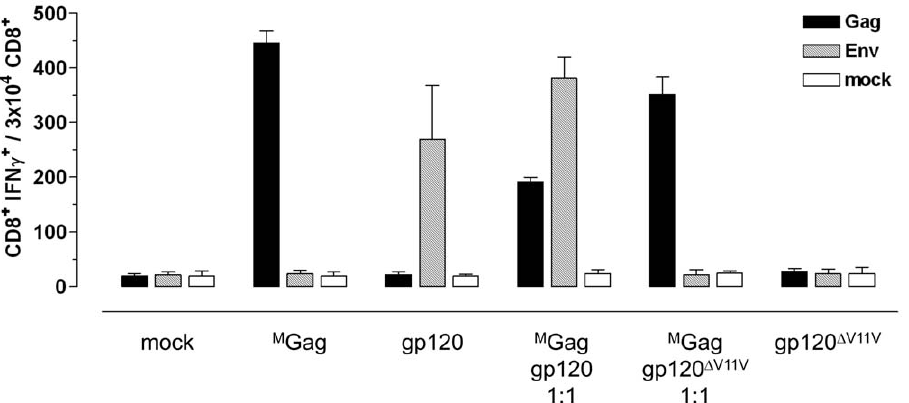
Figure 8. Impact of deleting the BALB/c immunodominant gp120 epitope V11V on Gag-specific CD8 + T cell immune responses. BALB/c mice (n=6 per group) were i.m. inoculated with (i) equimolar amounts of the indicated plasmid DNA construct (57 m g of M Gag, gp120, gp120 D V11V ), (ii) an equimolar mixture of M Gag and gp120, or (iii) an equimolar mixture of M Gag and gp120 D V11V . After 12 days, spleen cells were isolated and tested for specific cellular immune responses by measuring IFN c production after stimulation with Gag (black) or Env (hatched) specific peptides. IFN c production was determined using FACS analysis after intracellular staining of IFN c . Cell culture medium served as negative control. Data shown are representative of two experiments.